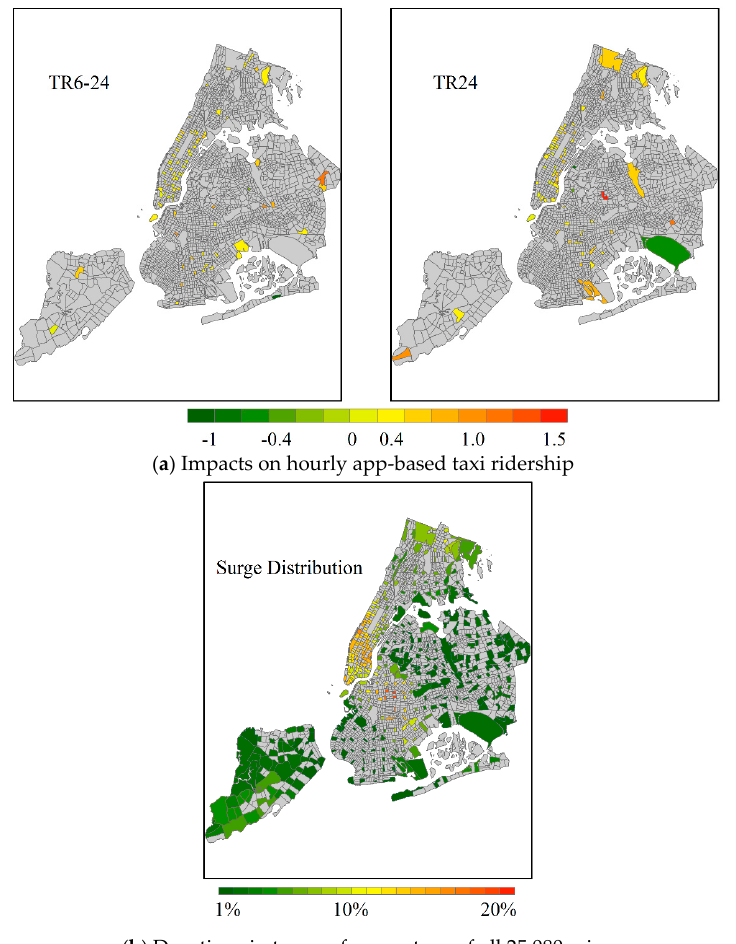
Figure 4. Impacts of durations of higher surge multiplier (>1.2). (Note grey regions mean the corresponding impacts are statistically insignificant). ISPRS Int. J. Geo-Inf. 2020 , 9 , x FOR PEER REVIEW